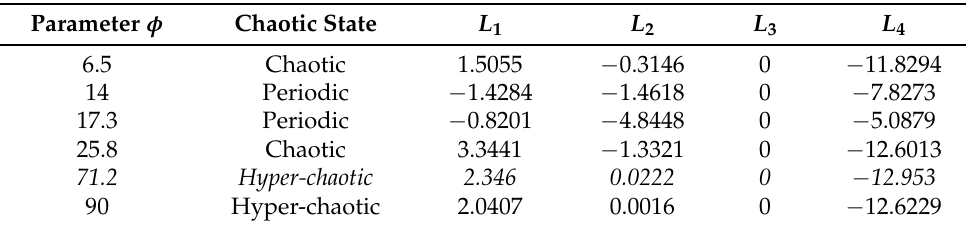
Table 2. LEs of selected states of hyper-chaotic fractional order Chen system (the best hyper-chaotic state is italicized).